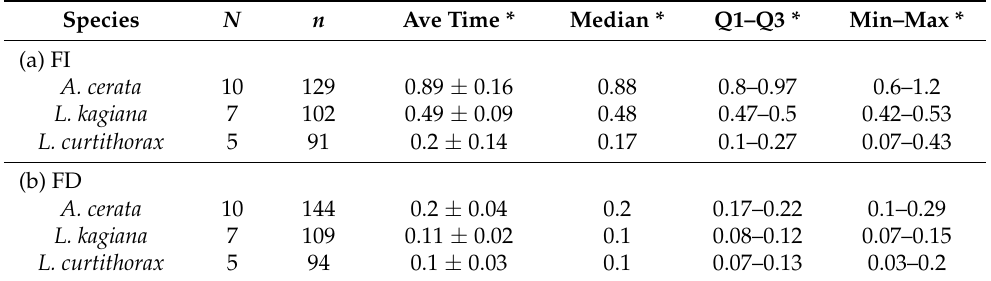
Table 1. Statistical results of FI and FD from flying males of A. cerata , L. kagiana and L. curtithorax . Species N n Ave Time * Median * Q1–Q3